Question: Write a single sentence explaining what this figure depicts.
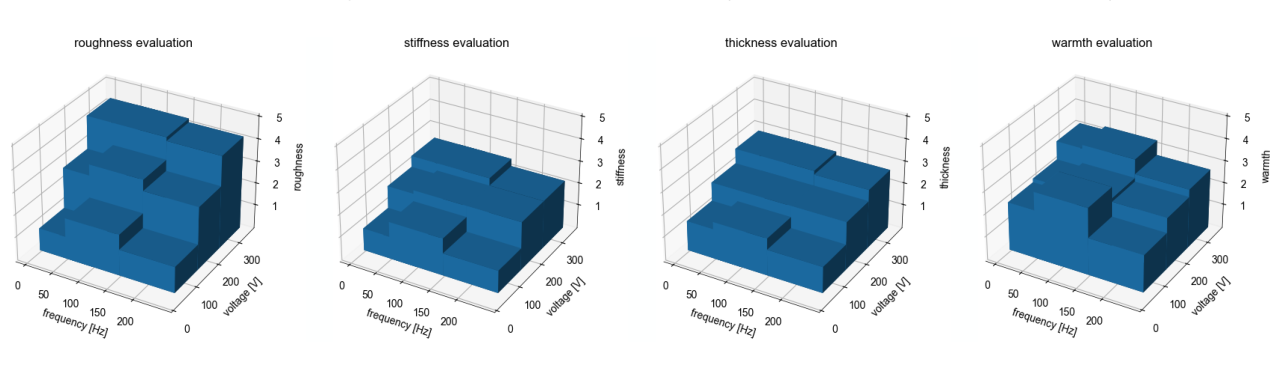
Answer: Distribution of means of Likert scale responses for each voltage and frequency.